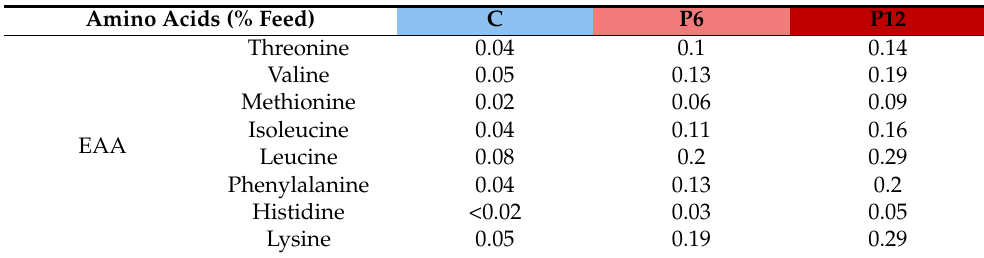
Figure 2. Peptide profile (%) of the experimental diets (C, P6, P12). Differences in molecular weight are presented in classes of kDa. Table 2. Free amino-acid composition of the experimental diets (%). EAA, essential amino acids. Sum free AA, summary of free amino acids.